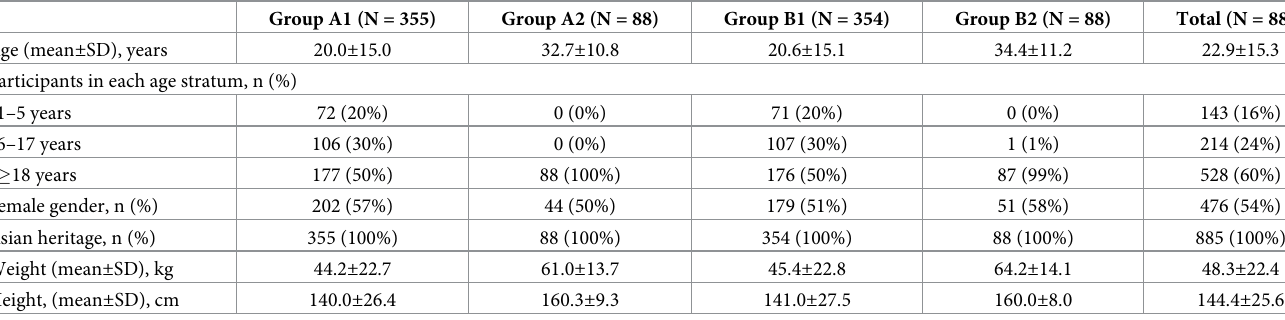
Table 1. Demographics characteristics of participants at